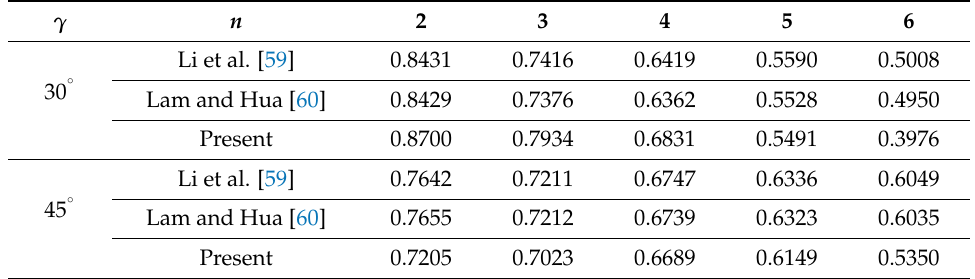
Table 1. Comparisons of non-dimensional frequency parameter of the isotropic truncated conical